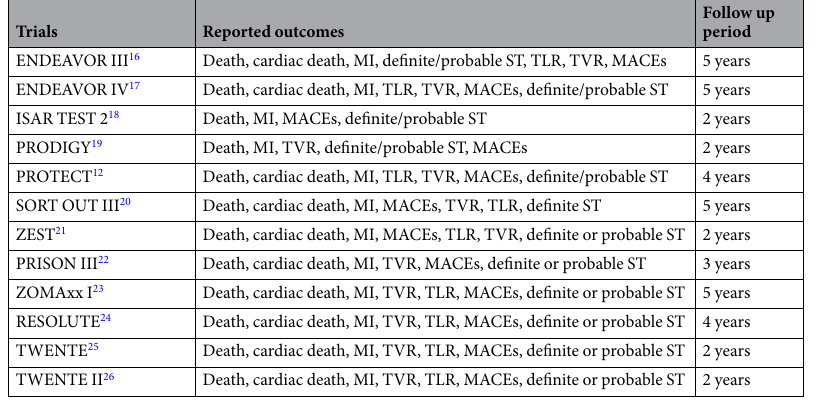
Table 1. Reported outcomes and follow up periods. Abbreviations: ST: stent thrombosis, TLR: target lesion revascularization, TVR: target vessel revascularization, MACEs: major adverse cardiac events, MI: myocardial infarction.